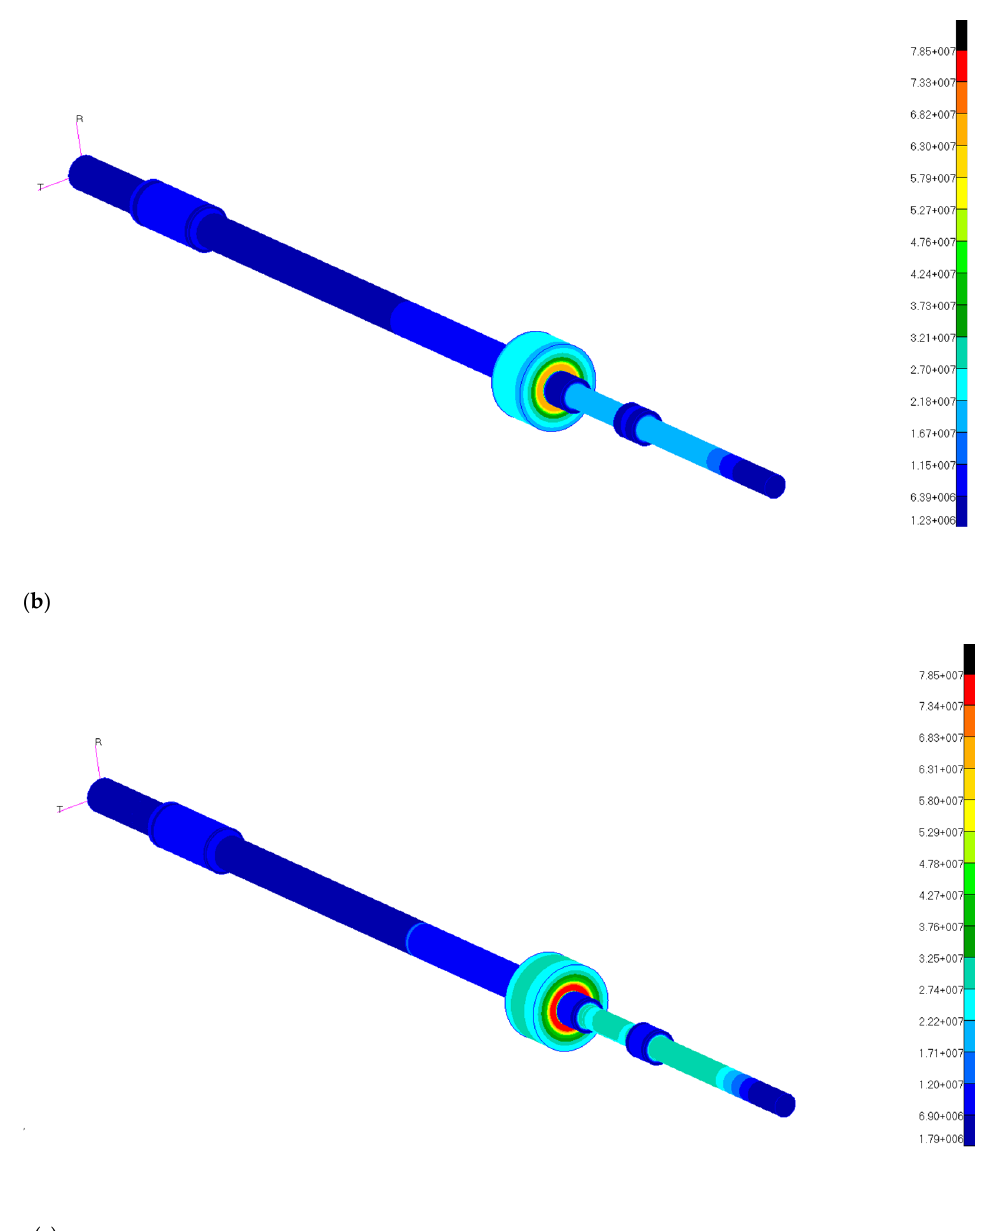
Figure 14. Shaft stresses. ( a ) stresses at 145,000 rpm, ( b ) stresses at 180,000 rpm, ( c ) stresses at 210,000 rpm.